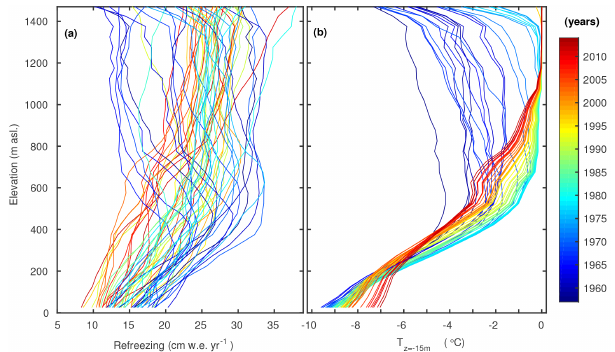
Figure 9. (a) Refreezing rate and (b) mean annual temperatures at 15m depth averaged over 50m altitude intervals from 1957 (blue) to 2014